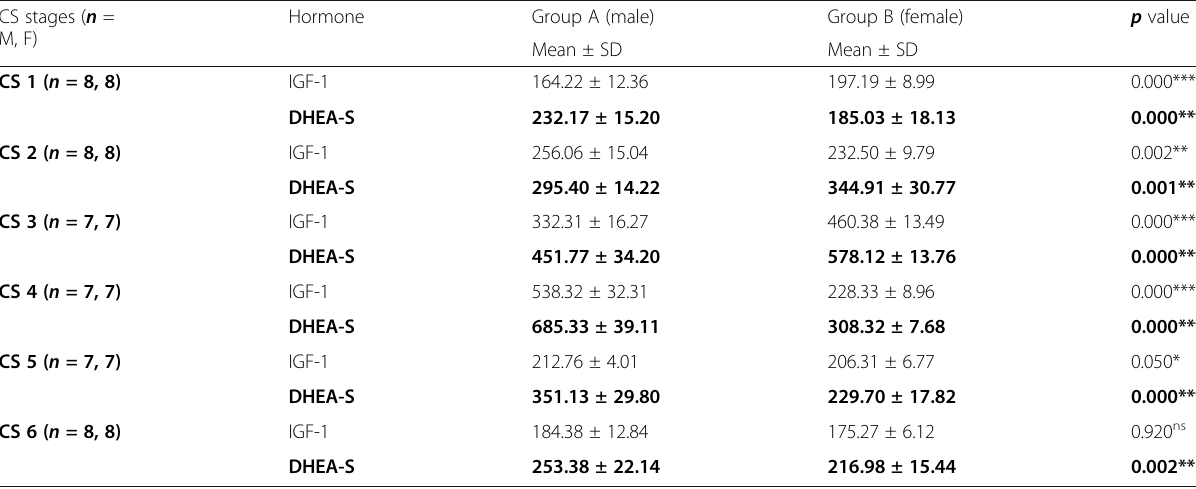
Table 1 Comparison of mean and standard deviation of IGF-1 (ng/ml) and DHEA-S (nmol/ml) levels among CS stages between group A and group